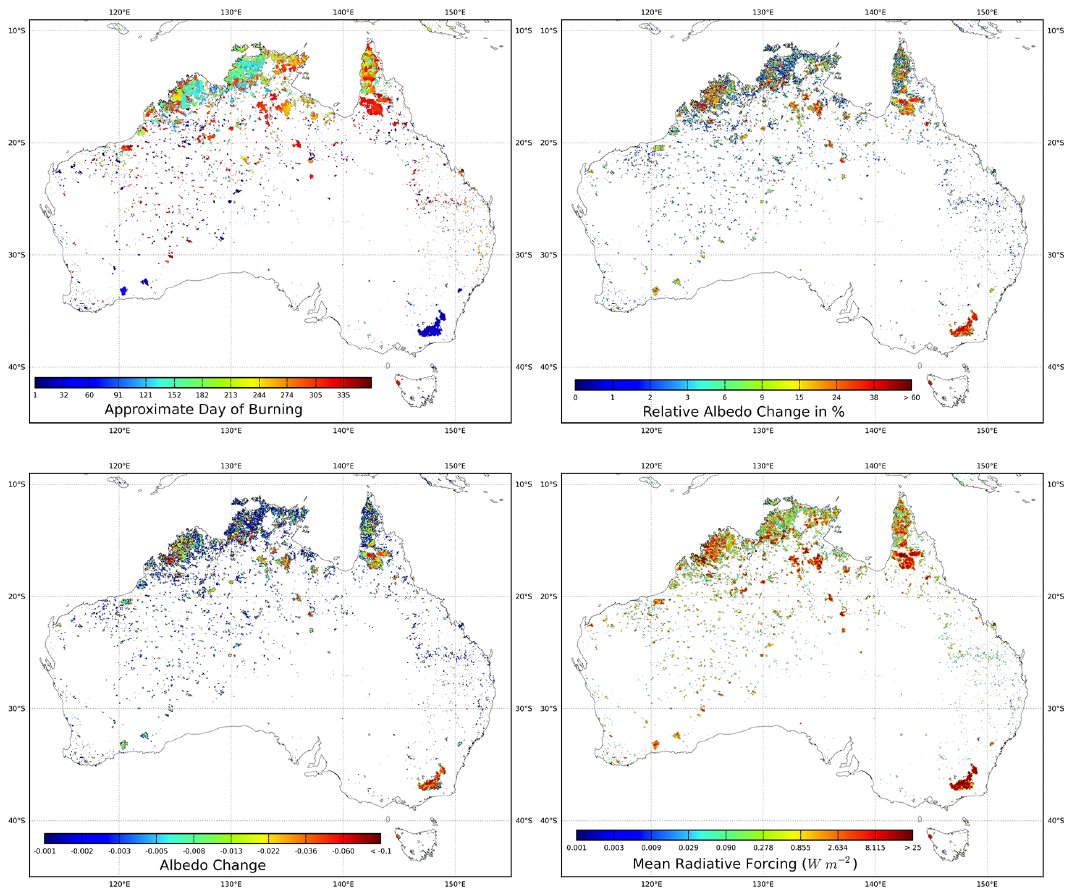
Figure 6. The approximate day of burning; the “instantaneous” shortwave albedo change in areas affected by fire; the relative albedo change in %; and the associated radiative forcing in Wm − 2 is shown for Australia during 2003.